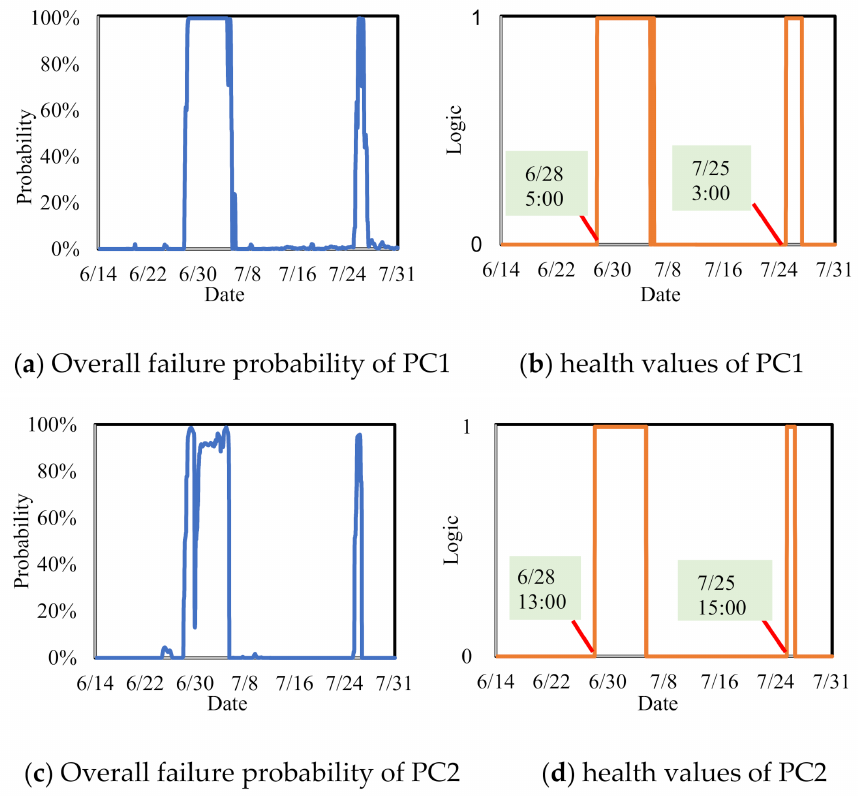
Figure 11. Overall failure probability and health values of the two principal component